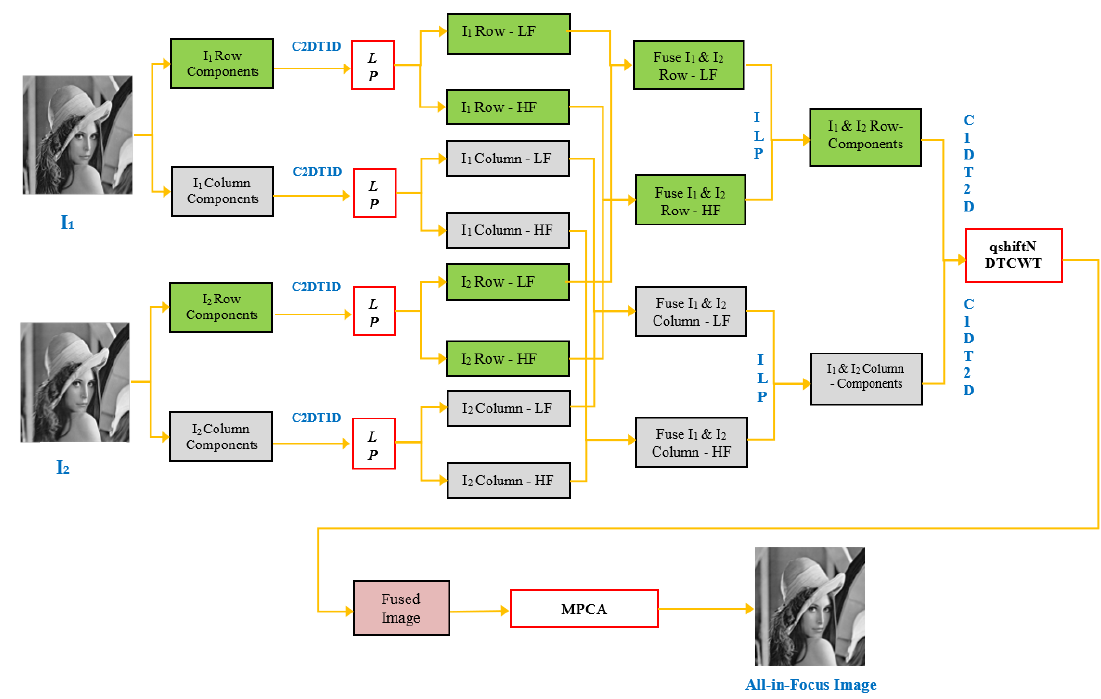
Figure 1. The flow diagram of the proposed qshiftN DTCWT-LP and MPCA-based image fusion algorithm.